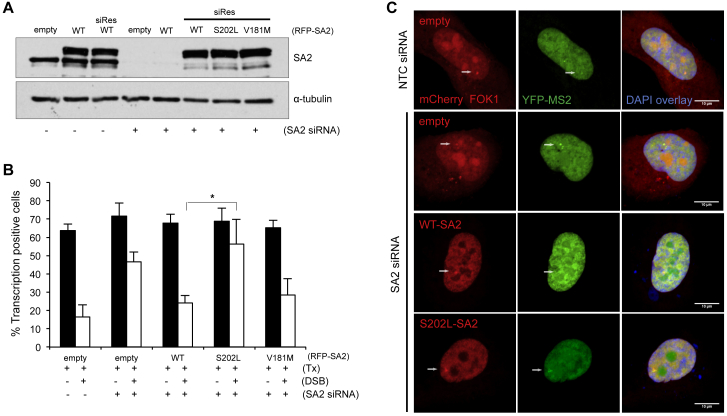
A Sister Chromatid Cohesion-Proficient Cancer-Associated SA2 Mutant Is Not Able to Support Transcriptional Repression at DNA DSBs(A) Western blot analysis of SA2 in whole-cell extracts prepared from cells following siRNA depletion (where indicated) and transfection with siRNA-sensitive or siRNA-resistant (siRes) SA2 constructs.(B) Quantification of transcription in U2OS reporter cells treated with siSA2 and transfected with the indicated siRNA-resistant SA2 construct with or without induction of the FokI endonuclease (DSB). 100 cells were analyzed per condition per repeat. Data represent the mean ± SD; n = 3 biological repeats. ∗p < 0.05, ∗∗p< 0.01 using paired Student’s t test.(C) Representative images of U2OS reporter cells analyzed in (B).See also Figure S4.